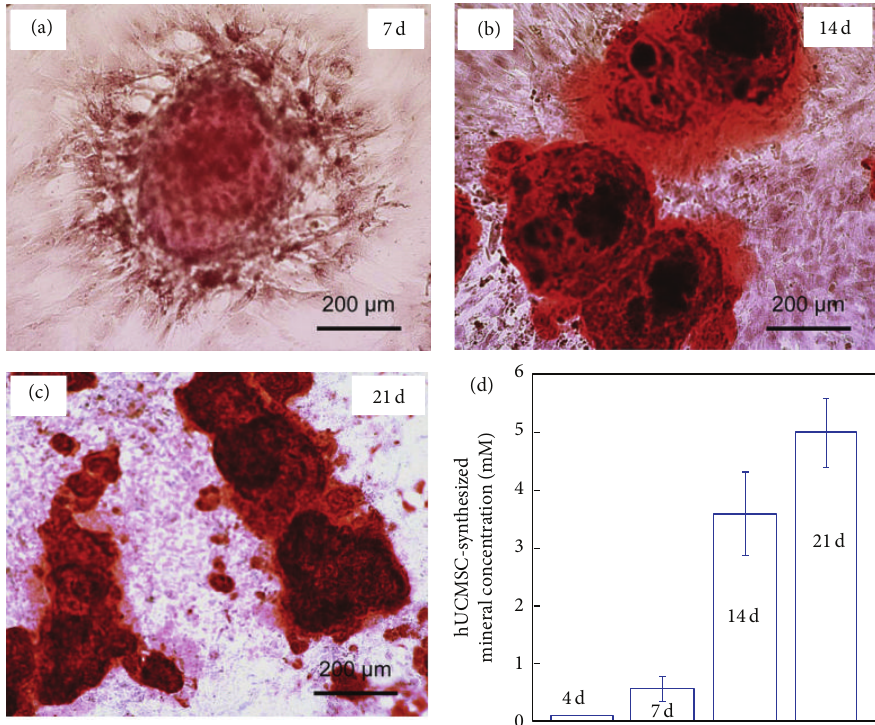
Figure 8: Alizarin staining for the synthesis of bone mineral at 7, 14, and 21 days. The calcium minerals are stained in red. The mineral concentration was measured by osteogenesis assay and the results are shown in (d). The mineral concentration at day 21 is 10-fold higher than day 7, which demonstrated cells released from microbeads synthesized bone mineral successfully